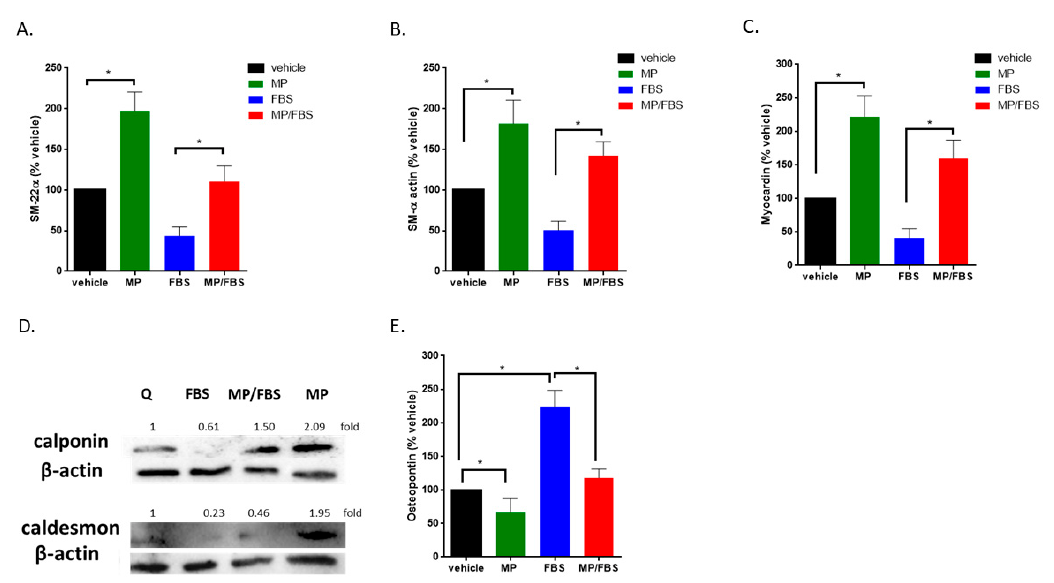
Figure 8. MP increases the expression of basal and FBS-attenuated di ff erentiation markers and decreases basal and FBS-induced expression of osteopontin. Cells were grown in starvation or complete medium, in presence or absence MP (100 µ M). Expression levels of contractile di ff erentiation markers ( A ) SM-22 α , ( B ) SM- α , ( C ) myocardin were evaluated by RT-PCR. Values represented are mean ± SEM of % vehicle control. (* p < 0.05). ( D ) Cells were grown in starvation or complete medium, in presence or absence MP (100 µ M). The expression of di ff erentiation markers, calponin and caldesmon, was determined by Western blotting. Values mean fold change of three independent experiments. ( E ) Cells were grown in starvation or complete medium, in presence or absence MP (100 µ M). The expression level of osteopontin was asssessed by RT-PCR. Values represented are mean ± SEM of % vehicle control. (* p < 0.05). One-way ANOVA followed by Tukey’s test was performed.